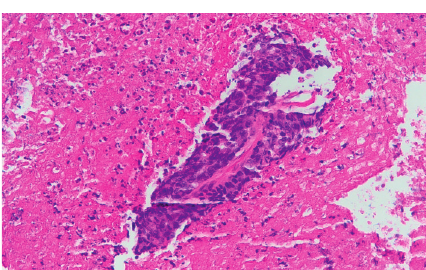
Figure 4: A group of malignant columnar shaped epithelioid cells in a background of abundant necroinflammatory